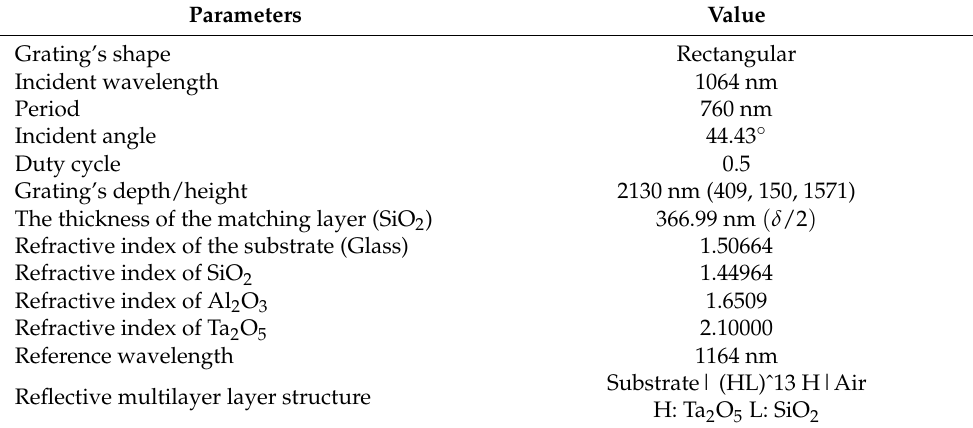
Table 2. Parameter of the three-layer